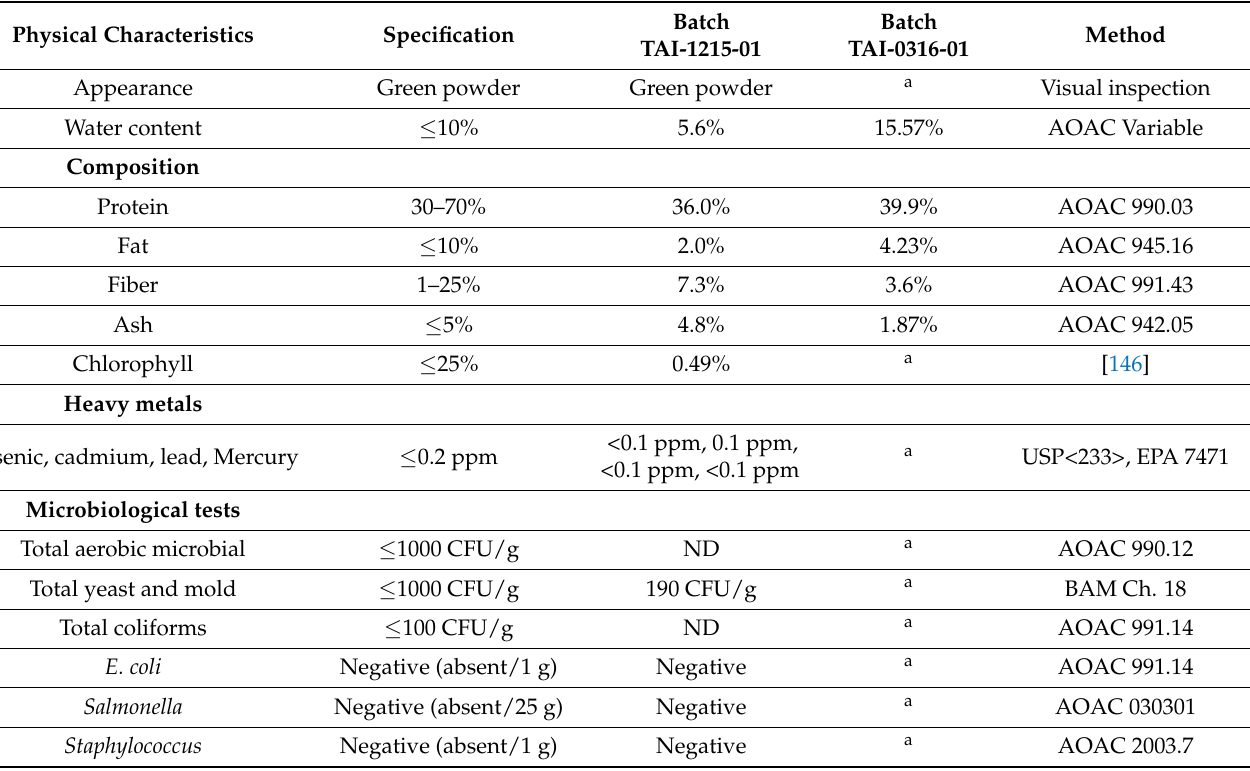
Table 4. Wild type C. reinhardtii (THN 6) dried biomass specifications (taken from the FDA application document [141] and Murbach et al. [142], and revised) and typical composition analysis results from two individual